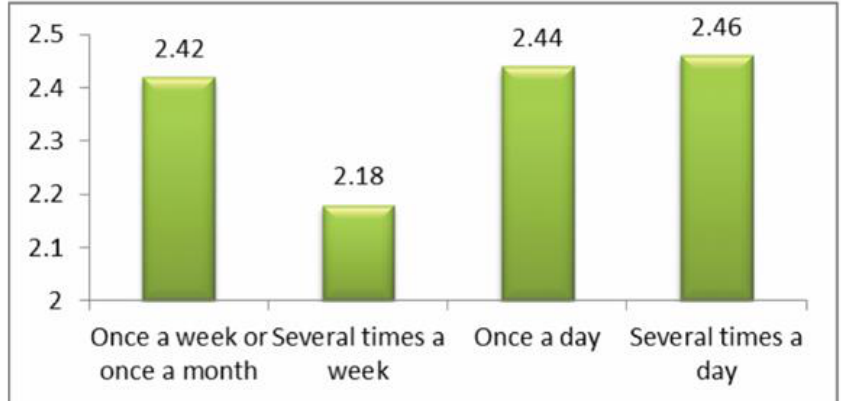
Figure 5. The risk of being a cybervictim (4-point scale), by the frequency of using the internet for the adolescents who were cyberbullied ( n = 163).